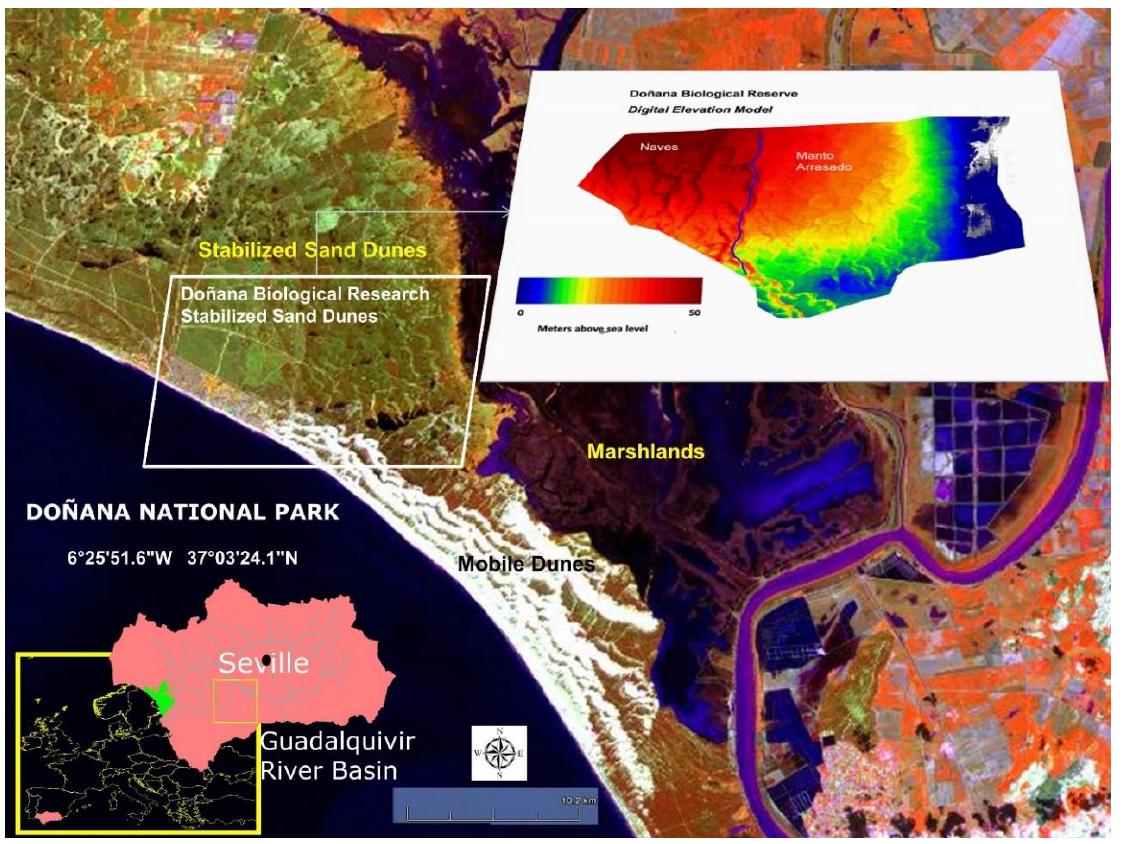
Figure 2. Location of Doñana National Park (SW, Spain). Square indicates the stabilized sand dunes ecosystem of Doñana Biological Reserve. The sub-image shows a digital elevation model of the study